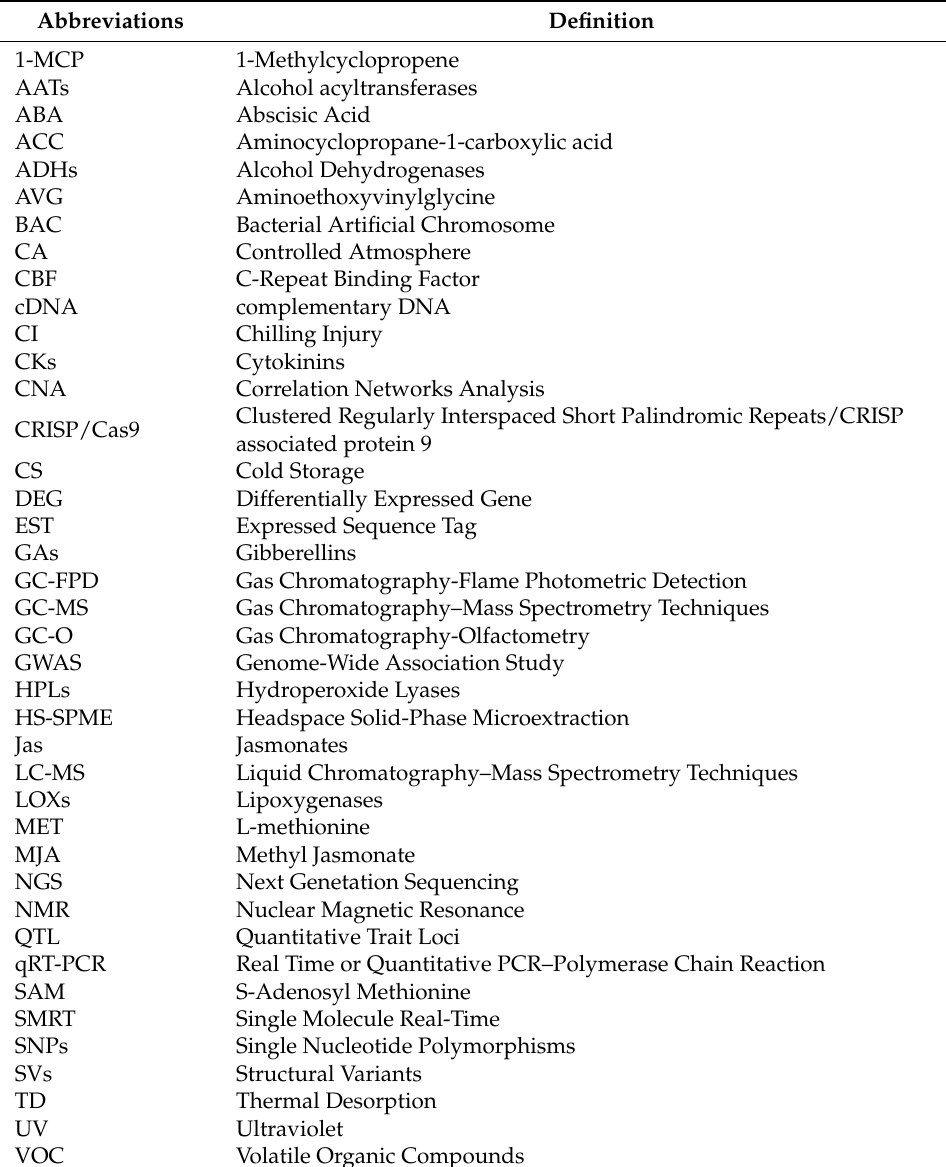
Table 1. List of abbreviations used in this